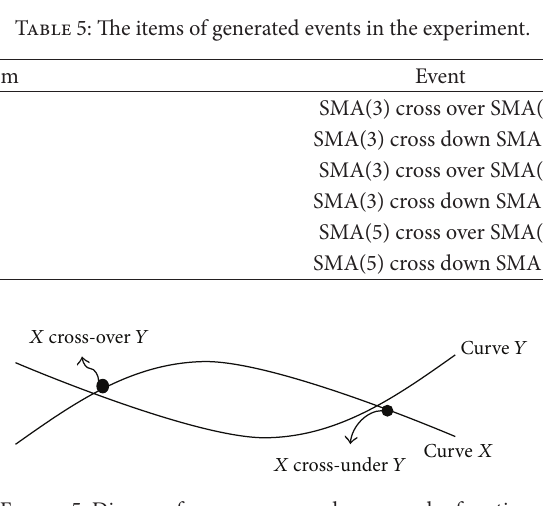
Figure 5: Diagram for cross-over and cross-under